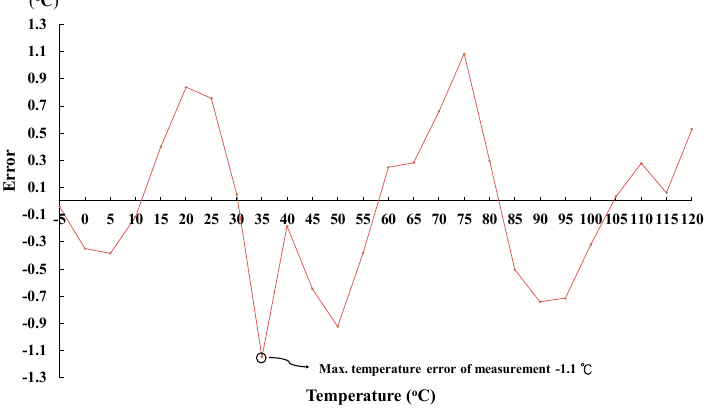
Figure 13. The measurement results of the proposed temperature sensor.